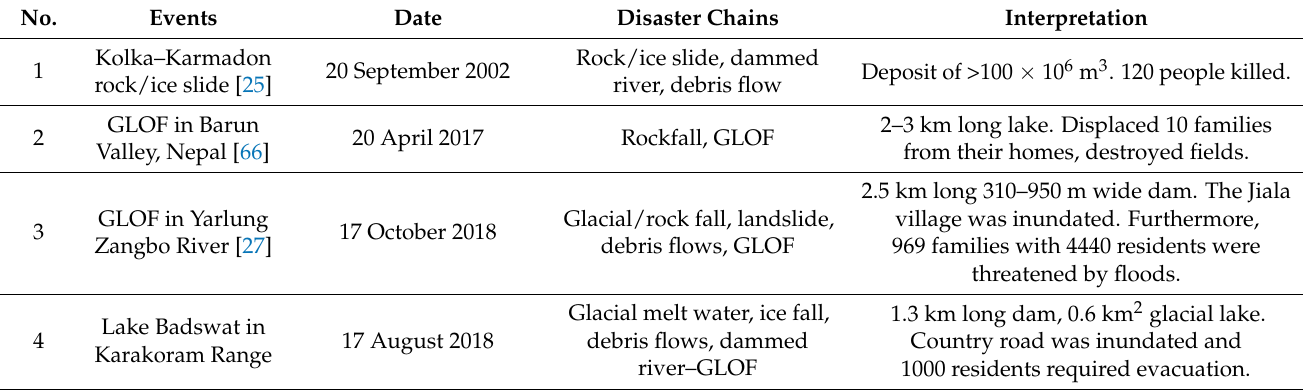
Table 2. Comparisons of various glacial-related